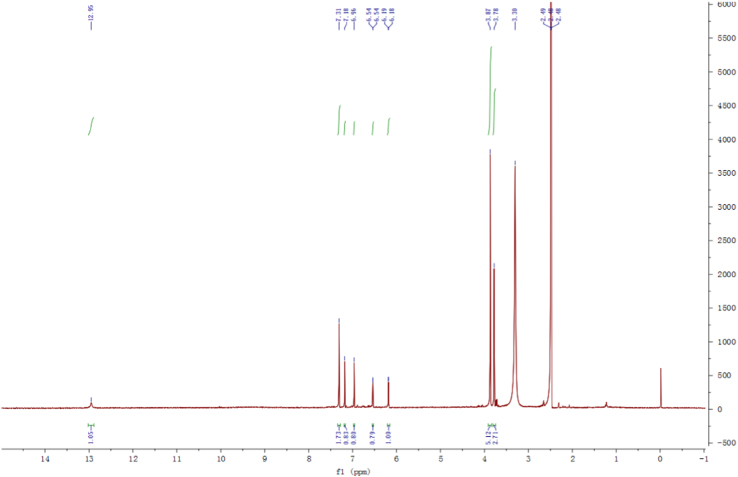
1H-NMR spectrum of compound 5.